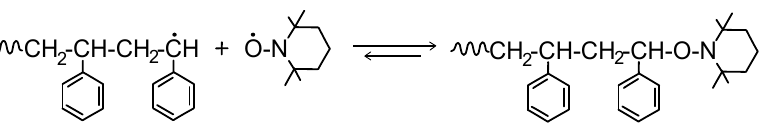
Figure 1. Depolymerization initiation reaction via oxygen–carbon bond rupture (nitroxide radical activation/deactivation).